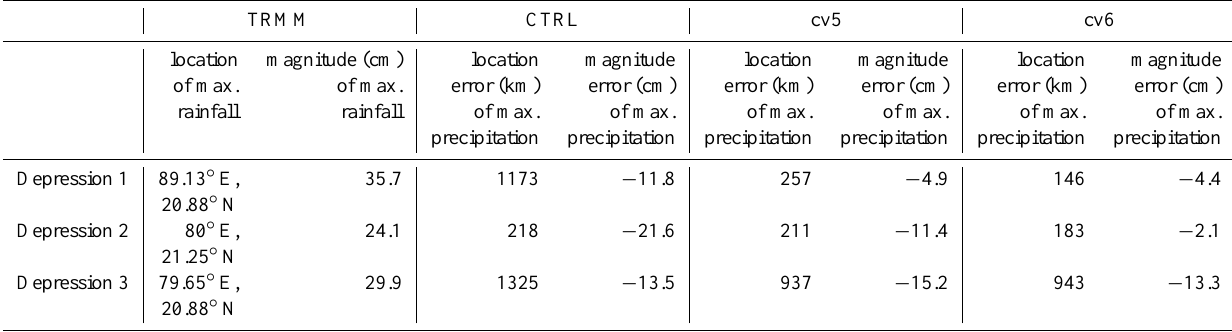
Table 2. Location and intensity of maximum precipitation (cm) as obtained from TRMM for all three depressions together with location and magnitude error of maximum precipitation for the CTRL, cv5 and cv6 runs. TRMM CTRL cv5 cv6 location magnitude (cm) location magnitude location magnitude location magnitude of max. of max. error (km) error (cm) error (km) error (cm) error (km) error (cm) rainfall rainfall of max. of max. of max. of max. of max. of max. precipitation precipitation precipitation precipitation precipitation